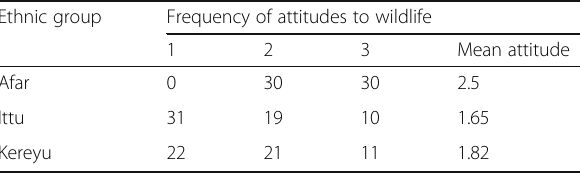
Table 3 Frequency of attitudes towards wildlife by ethnic groups around Awash National Park (ANP), Ethiopia, ( n = 180) on a scale, where 1 = negative, 2 = neutral, and 3 = positive Ethnic group Frequency of attitudes to